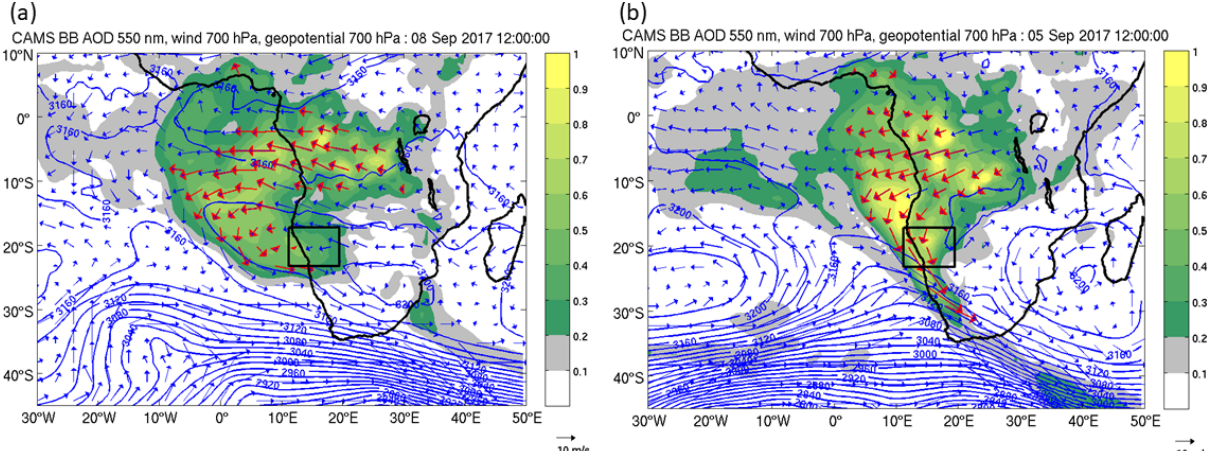
Figure 2. Regional atmospheric circulation and aerosol for (a) 8 September 2017 and (b) 5 September 2017 at 12:00UTC. Geopotential height (contours) and wind (arrows) at 700hPa and biomass burning AOD at 550nm (shading) from CAMS reanalysis are displayed. Red arrows highlight wind vectors at grid points where the AOD is higher than the 90th percentile of the regional AOD. The AEROCLO-sA campaign region is shown with a black rectangle in the Namibian